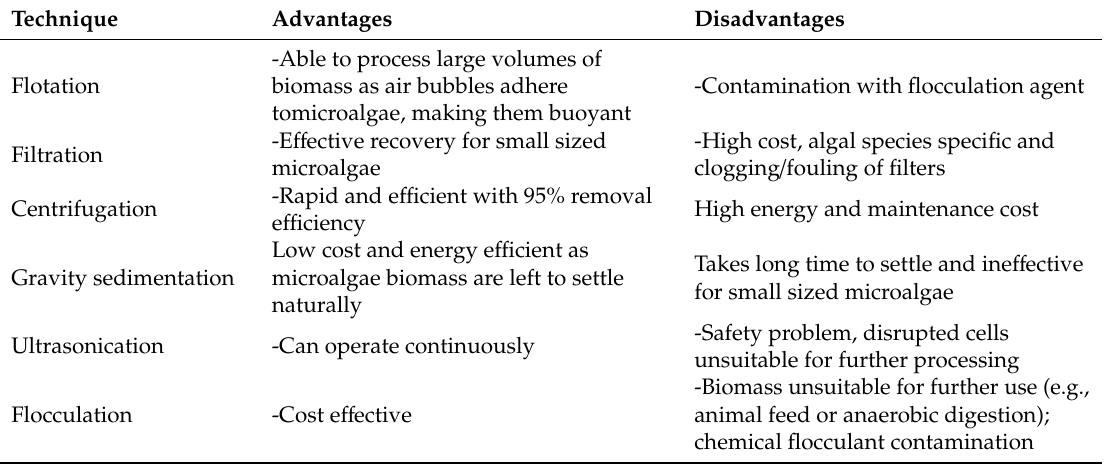
Table 6. Harvesting techniques of microalgae